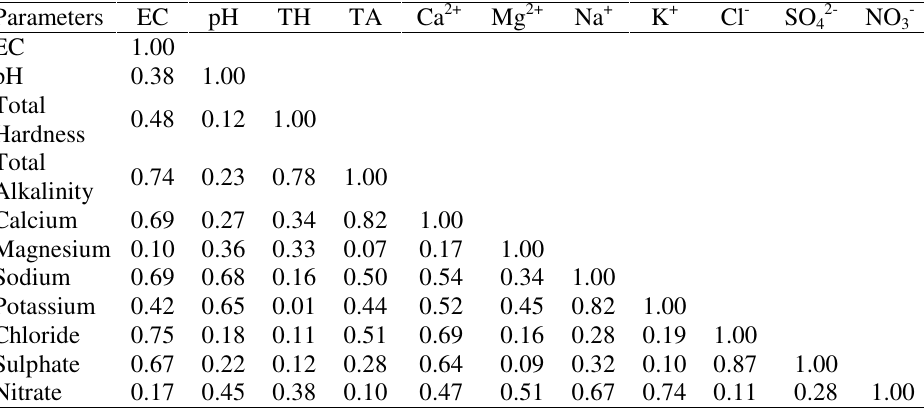
Table 5. Correlation coefficient (r) for different